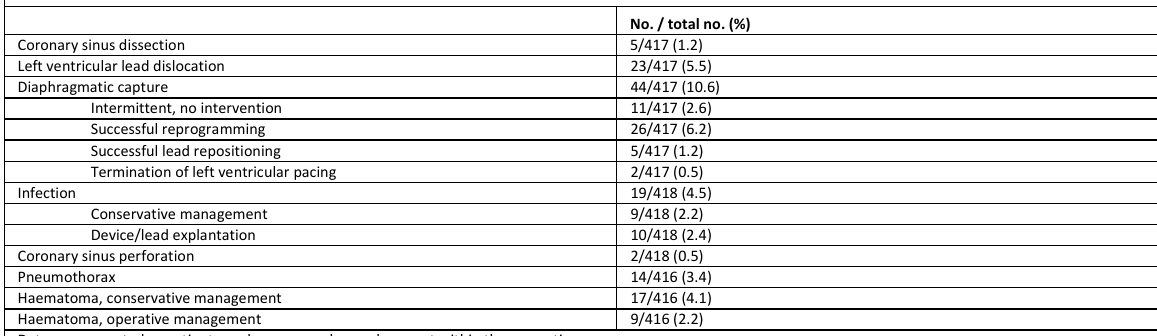
Table S5B: Peri- and postoperative complications.